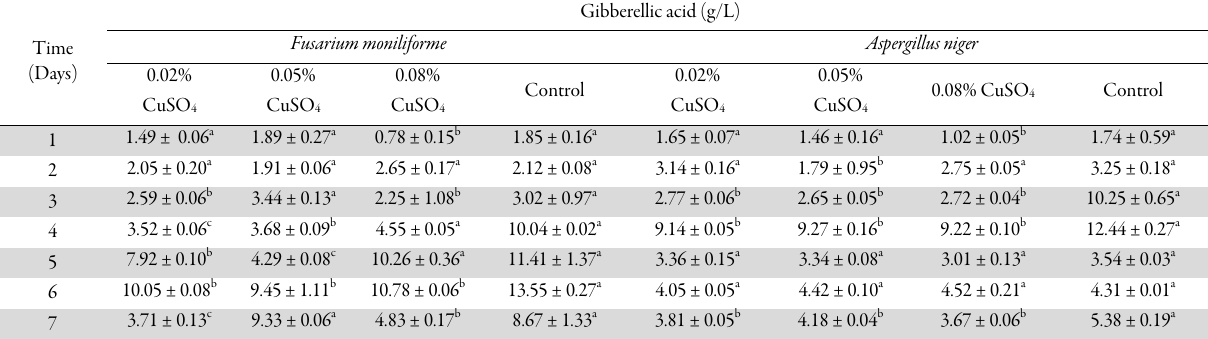
Values represented are means ±SD of amount of Gibberellic acid. Means with the same superscript across a column are not statistically different from each other Table 3. Production of gibberellic acid by submerged fermentation of banana peel using F. moniliforme and A. niger under optimized conditions Time (Days)